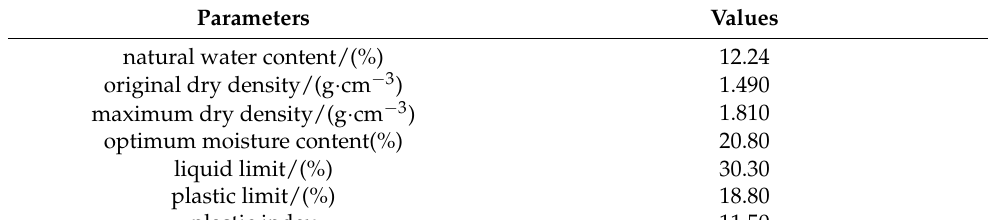
Figure 2. Particle gradation curve of the test soil. Table 2. Basic physical parameters of the soil.